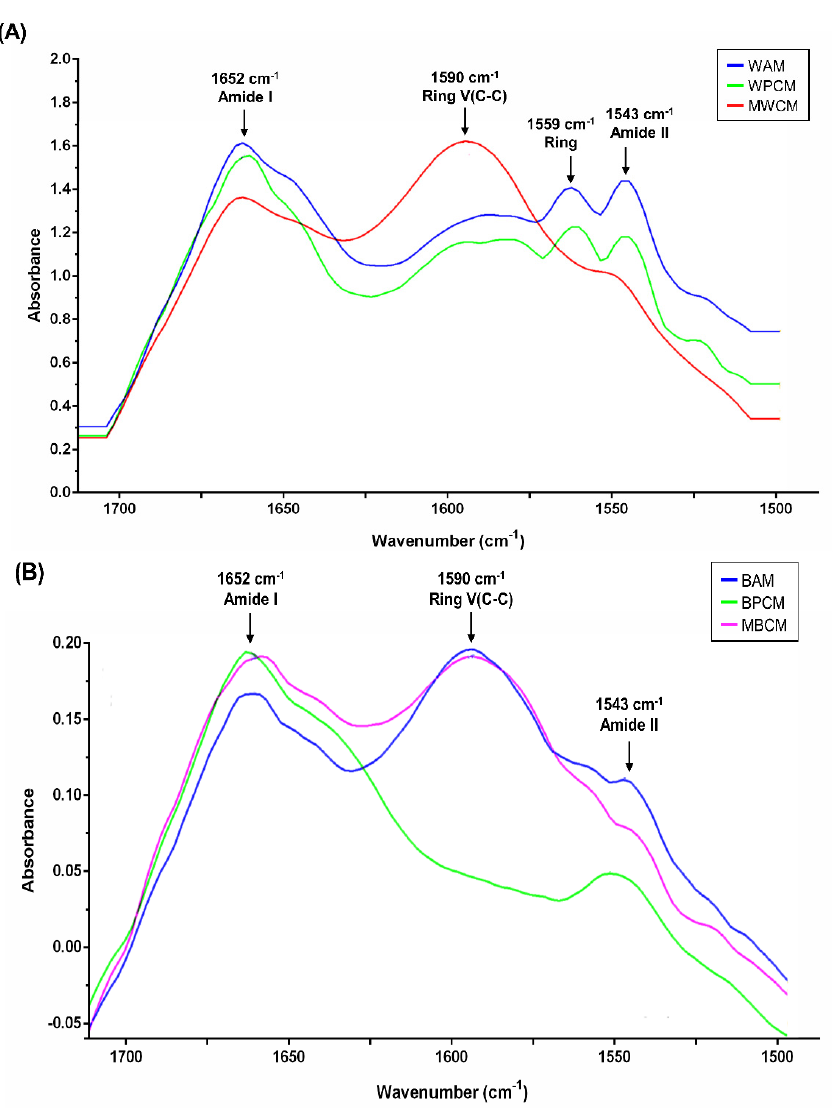
Figure 2. FTIR spectra of various adipocyte-conditioned media. ( A ) MWCM (red), WPCM (green) and WAM (blue), ( B ) MBCM (pink), BPCM (green) and BAM (blue).